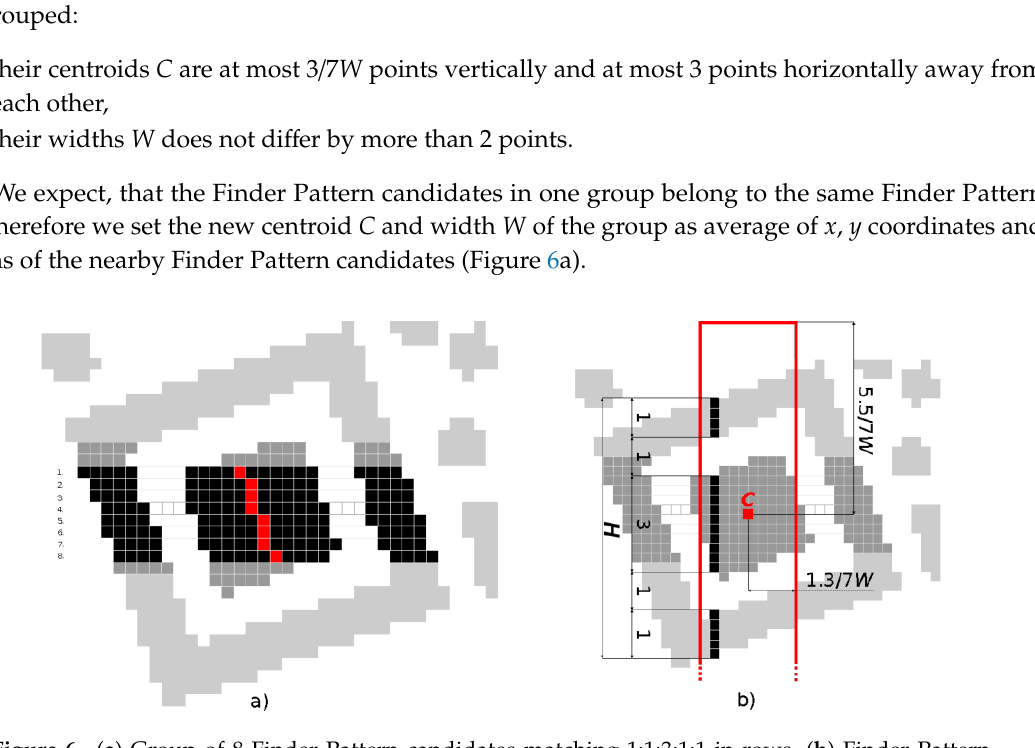
Figure 6. ( a ) Group of 8 Finder Pattern candidates matching 1:1:3:1:1 in rows, ( b ) Finder Pattern candidate matching 1:1:3:1:1 vertically.